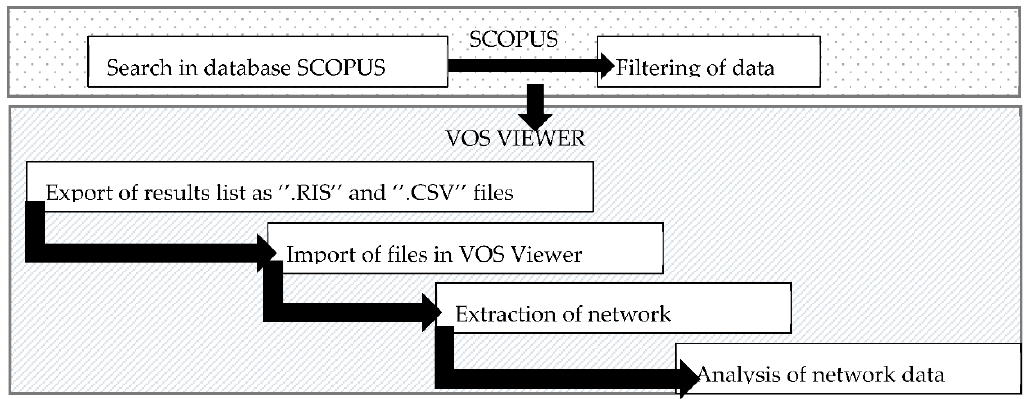
Figure 5. The procedure of network analysis. Source: created by the authors.